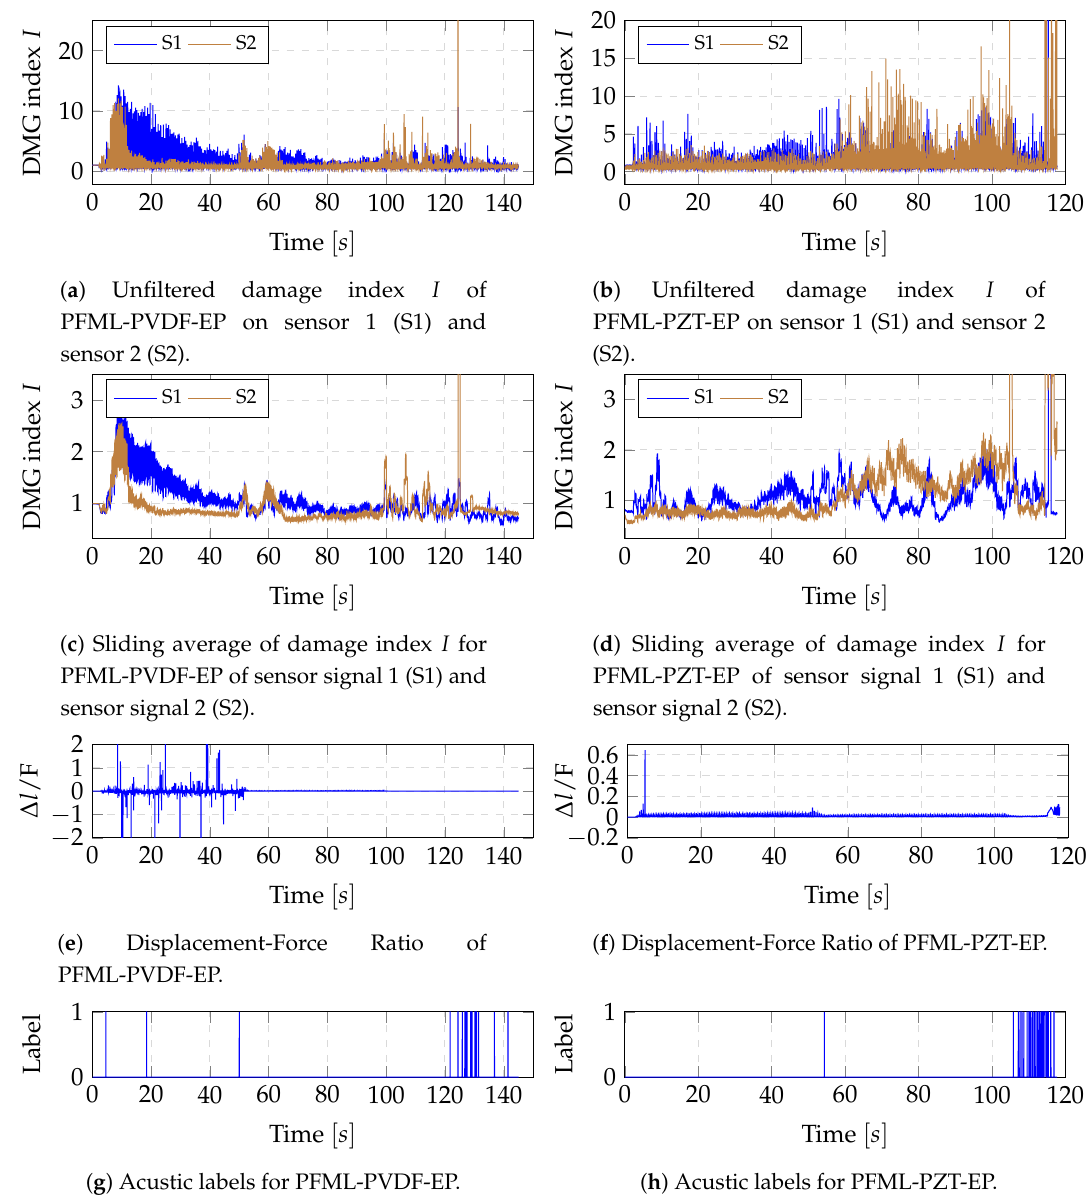
Figure 11. Results of DMG index analysis for one example of PFML-PZT-EP and PFML-PVDF-EP in the dynamic test